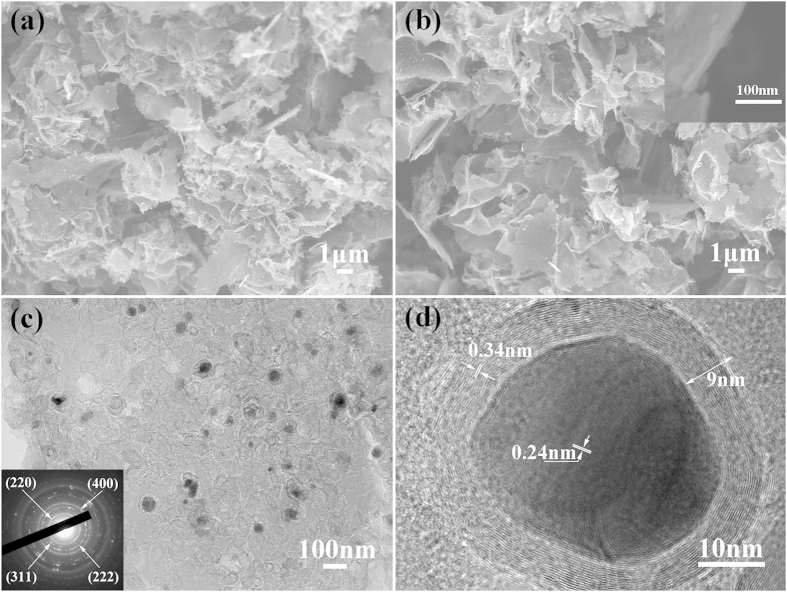
(a) SEM image of Co@C@PGC nanosheets; (b) SEM image of Co3O4@C@PGC nanosheets and the inset is SEM image of high magnification; (c) TEM and (d) HRTEM image of Co3O4@C@PGC nanosheets.